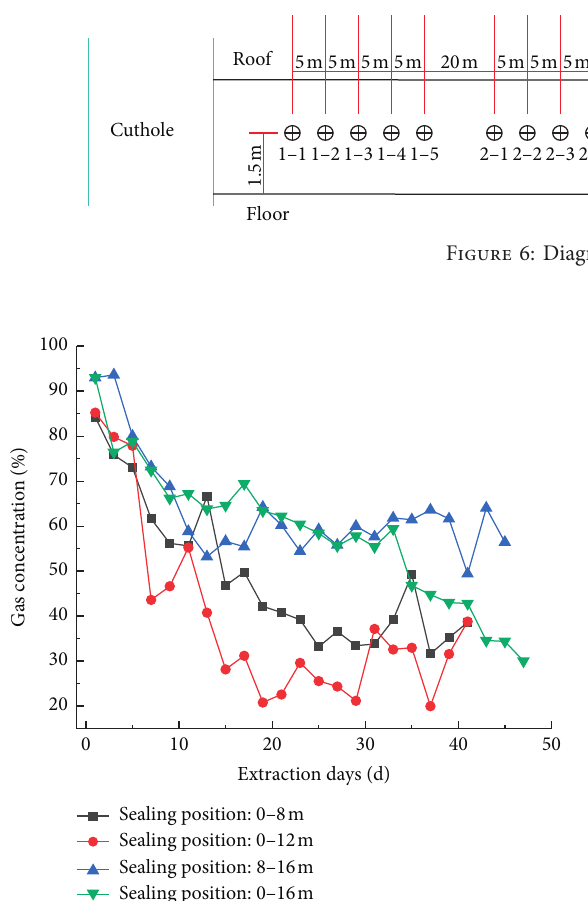
Figure 7: Curve of borehole gas concentration changing with time.